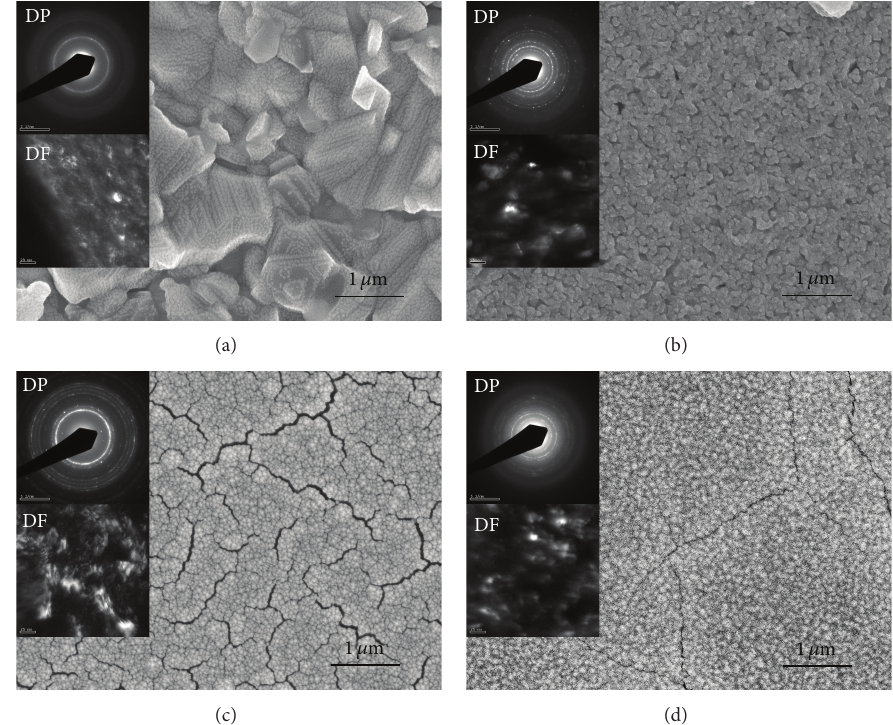
Figure 3: The plan-view micrographs of the as-annealed (a) FCN film; (b) CFCN film; (c) AFCN film; and (d) TFCN film, respectively. The insets are the corresponding SAD (marked by DP) and DF image (marked by DF) of each as-annealed thin film.